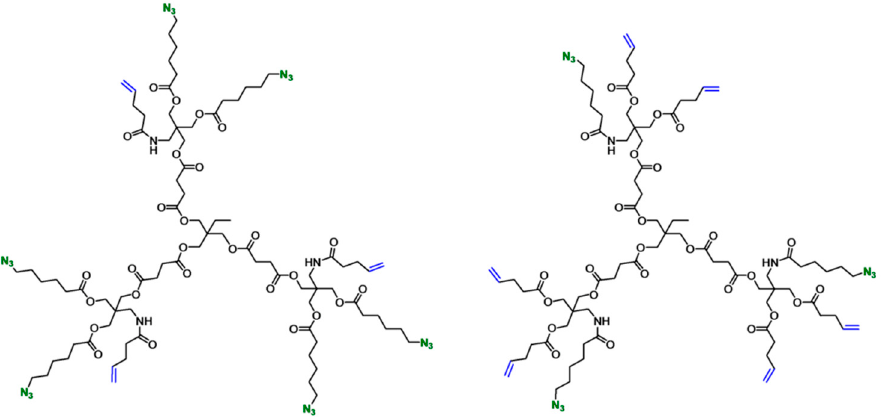
Figure 9. Polyester dendritic scaffolds displaying three alkene and six azide groups ( left ) and six alkene and three azide groups ( right ). Adapted from [25], published by The Royal Society of Chemistry.